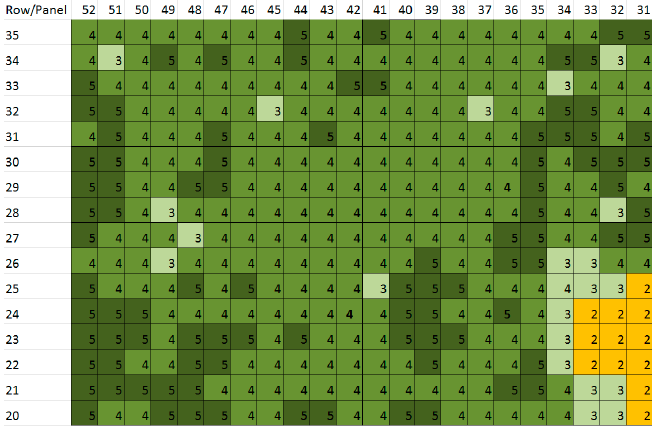
Figure 8. Results of traditional expert-based assessment of grapevines vigour per panel (groups of